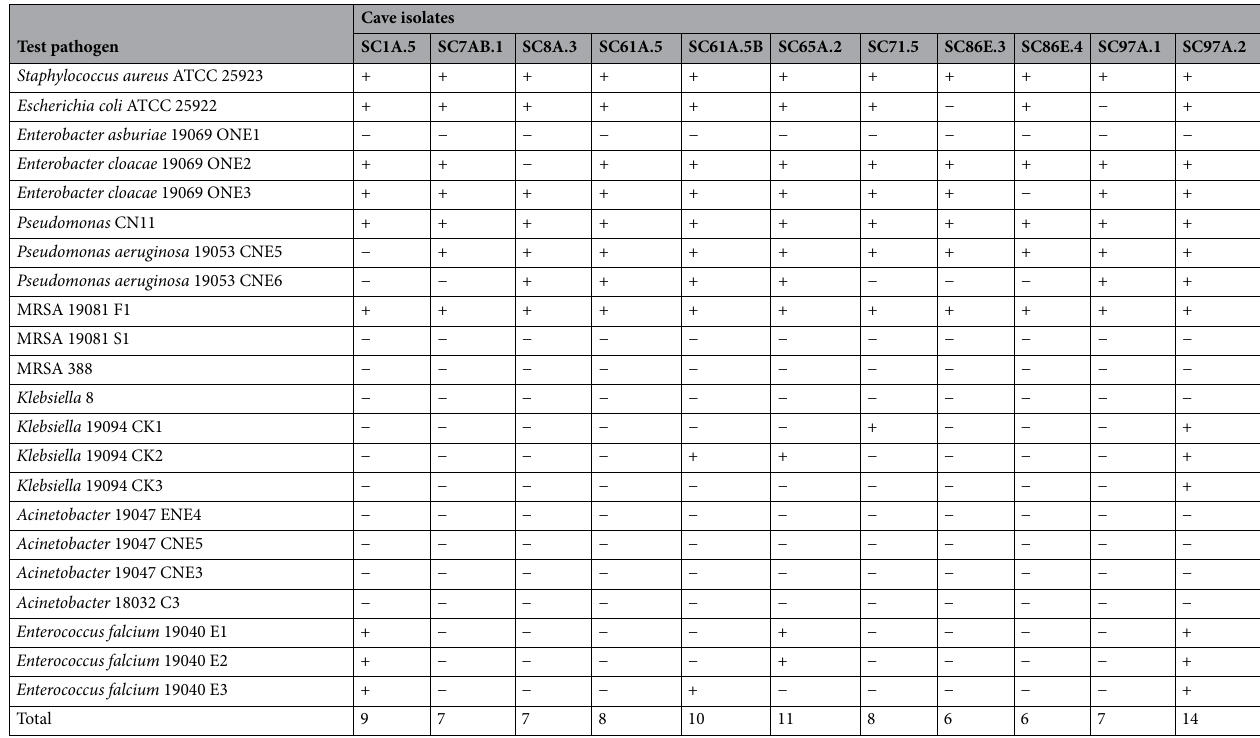
Table 4. Antimicrobial activity of Scarisoara ice cave bacteria. The inhibitory response of the ATCC and clinical isolates corresponded to (+) presence of inhibition ring, and (−) absence of inhibition ring, as indicated in “Methods”